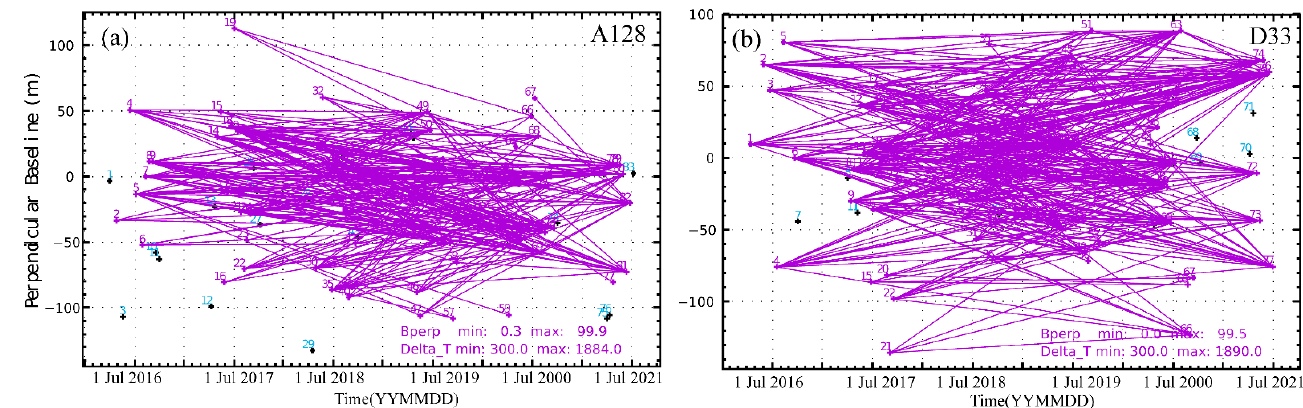
Figure 2. Distribution of temporal and spatial baselines of the interferograms. Crosses with purple labels represent images included in velocity calculations, whereas crosses with cyan labels represent images that were not included. Purple lines represent generated interferograms. ( a ) Track A128; ( b ) Track D33.